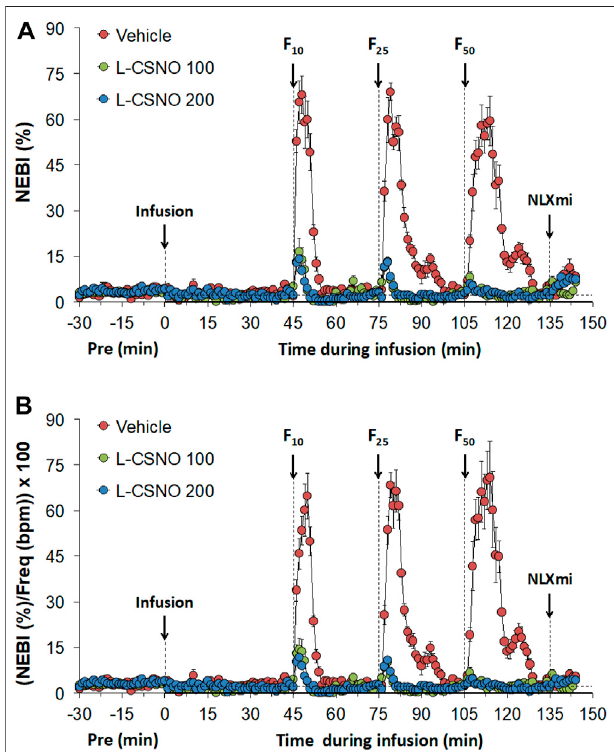
FIGURE 9 | Non-eupneic breathing index (NEBI) (A) and NEBI/ Frequency of breathing (NEBI/Freq) (B) values. The infusion of vehicle (20 μ l/ min, IV),L-CSNO100(S-nitroso-L-cysteine, 100 nmol/kg/min, IV)or L-CSNO 200 (S-nitroso-L-cysteine, 200 nmol/kg/min, IV) commenced at time 0. Bolus intravenous injections of fentanyl at F10 (10 μ g/kg, IV), F25 (25 μ g/kg, IV), and F50 (50 μ g/kg, IV) were given at 45, 75, and 105 min, respectively. A bolus intravenous injection of naloxone methiodide (NLXmi, 1.5 mg/kg, IV) was given at time 135 min. The data are presented as mean ± SEM. There were 8 rats in each group.